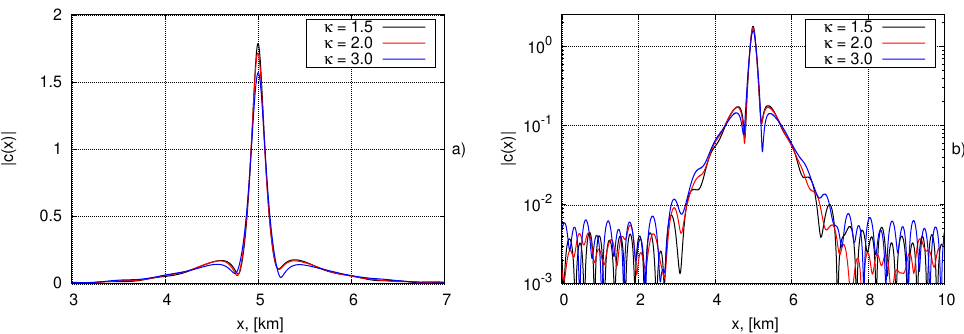
Figure 1. Profiles |c(x)| of bound structures formed by two single breathers with µ ini = 0.2 and different κ in normal ( a ) and log ( b ) scales. Profiles plotted after damping is switched